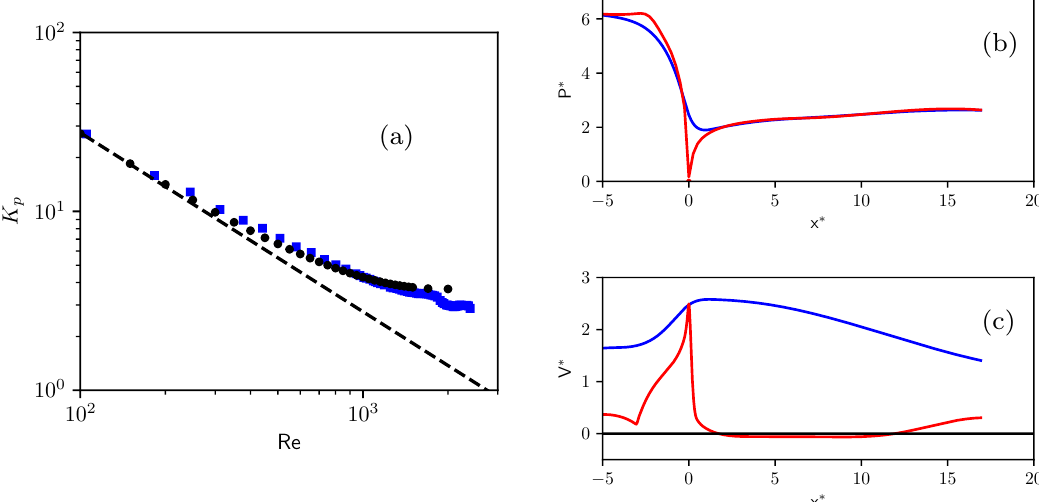
Figure 4. Main results of the single-phase numerical simulations. ( a ) Pressure loss coefficient K p as a function of the Reynolds number Re . Blue squares represent experimental values while black squares represent numerical simulations. The dashed line is a line of equation K p ∝ Re − 1 . ( b ) Dimensionless ρ V 2 pressure profile P ∗ = P / 1 with respect to axial coordinate X ∗ = X / h throat . ( c ) Dimensionless in 2 velocity profile V ∗ = V / V in with respect to X ∗ . For both images ( b , c ): Re = 1200, σ 1 = 6.57 and σ 2 = 2.58; Blue line is along the horizontal line Z ∗ = 0.5 and Y ∗ = 0; Red line is a broken line following the bottom of the vein, 0.5 mm above it at Y ∗ =